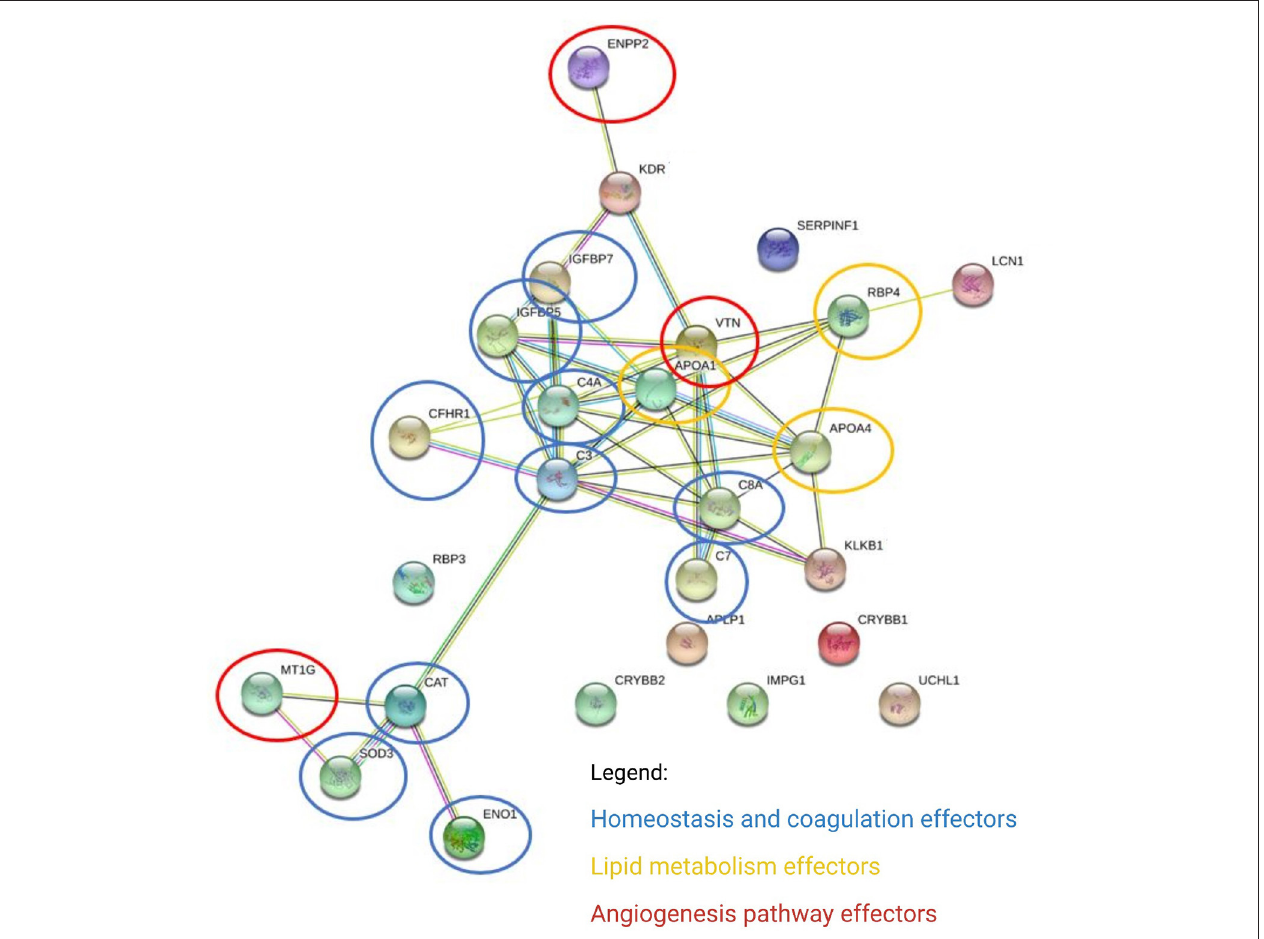
FIGURE 4 | Differentially expressed proteins converge on main pathways by biological processes. The links between proteins represent interactions, according to the pattern of the String program (protein-protein interaction network enriched with functional analysis). ENPP2, ectonucleotide pyrophosphatase/ phosphodiesterase family member 2; KDR, kinase insert domain receptor (A type III receptor tyrosine kinase), isoform CRA_a; IGFBP7, insulin-like growth factor-binding protein 7; IGFBP5, insulin-like growth factor-binding protein 5; CFHR1, complement factor H-related protein 1; C4A, complement C4-A; APOA1, apolipoprotein A-I, isoform CRA_a; VTNC, vitronectin; C3, tetranectin; C8A, complement component C8 alpha-chain; APOA4, apolipoprotein A-IV; RBP4, retinol-binding protein 4; SERPINF1, pigment epithelium-derived factor; LCN1, lipocalin 1 (tear prealbumin), isoform CRA_a; C7, complement component C7; APCP1, amyloid-like protein 1; CRYBB2, beta-crystallin B2; IMPG1, interphotoreceptor matrix proteoglycan 1; CRYBB1, beta-crystallin B1; UCHL1, ubiquitin carboxy-terminal hydrolase; KLKB1, plasma kallikrein; RBP3, retinol-binding protein 3; CAT, cathepsin D; MT1G, metallothionein 1G; SOD3, extracellular superoxide dismutase [Cu-Zn]; ENO1, enolase 1